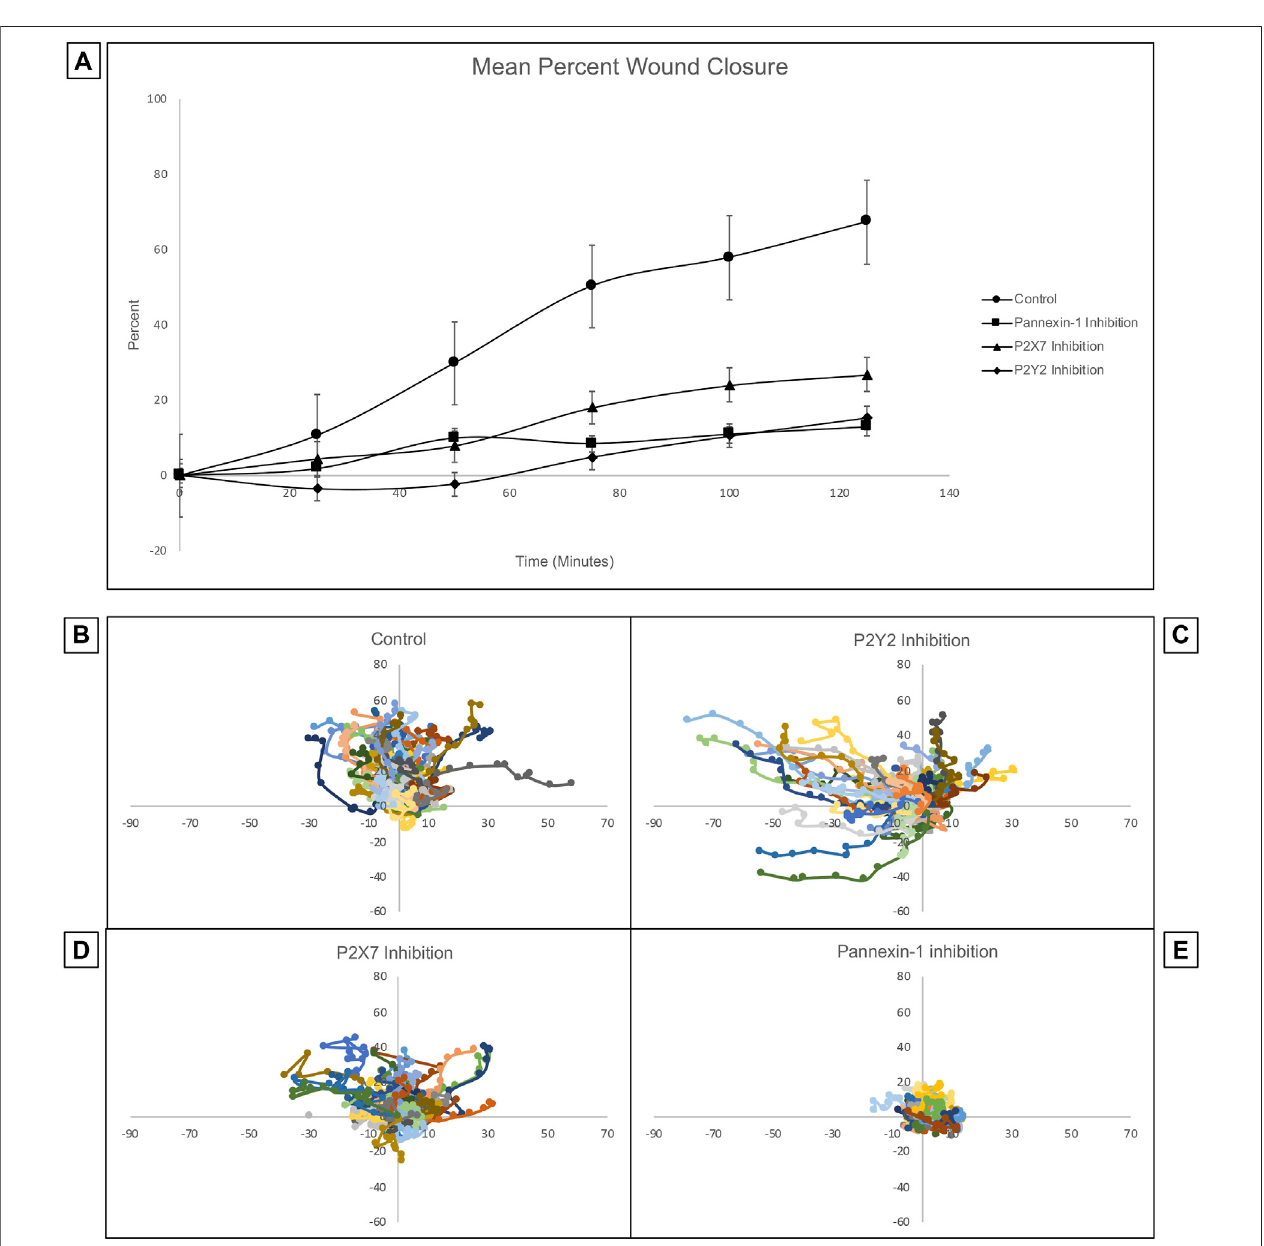
FIGURE 8 | Inhibition of pannexin-1, P2X7, or P2Y2 have different effects on cellular trajectory at the wound edge but all decrease percent wound closure. Con fl uent Human Corneal Limbal Epithelial cell cultures were pre-incubated in the presence or absence of inhibitors, stained with the SiR Actin, scratch-wounded, and imaged at arate of one frame per 5 min for 2 h using the Zeiss LSM 880 confocal microscope. (A) Inhibition of pannexin-1, P2X7, or P2Y2 led to signi fi cantly diminished woundclosureat the 2 h time point. Two-tailed Student ’ st-tests were performed tocompare thepercentwound closure ofeach inhibitor toan uninhibitedcontrol (* p < 0.05forall inhibitors). Thepathofindividualcells atthewoundedge wasplottedusingImageJandnormalizedsothatmotility towards thewoundisrepresentedas movement along the y-axis in the positive direction, and movement in the parallel direction is plotted along the x-axis. Controls (B) were scratch-wounded but not pre- incubated with an inhibitor. (C) Pre-incubation with ArC 118925XX, a competitive inhibitor to P2Y2, results in uncoordinated and undirected migration. (D) Pre- incubationwithA438079,acompetitiveinhibitortoP2X7,causescellstoremainclosertotheirlocationoforiginthantheydoincontrols. (E) Pre-incubationwith10PanX, aninhibitortopannexin-1,causescellstoremainclosertotheirpositionoforiginthaninboththecontrolandintheP2X7-inhibitedconditions.Datarepresentsaminimum of three independent experiments for each condition.